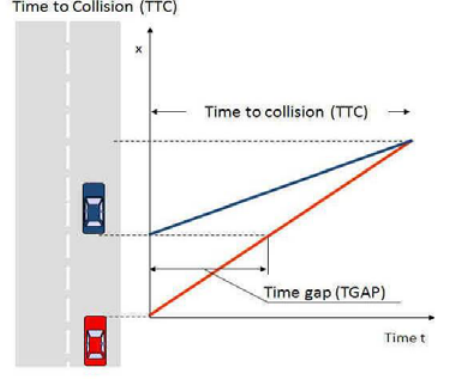
Fig. 2 Definition of the Time to Collision (TTC)